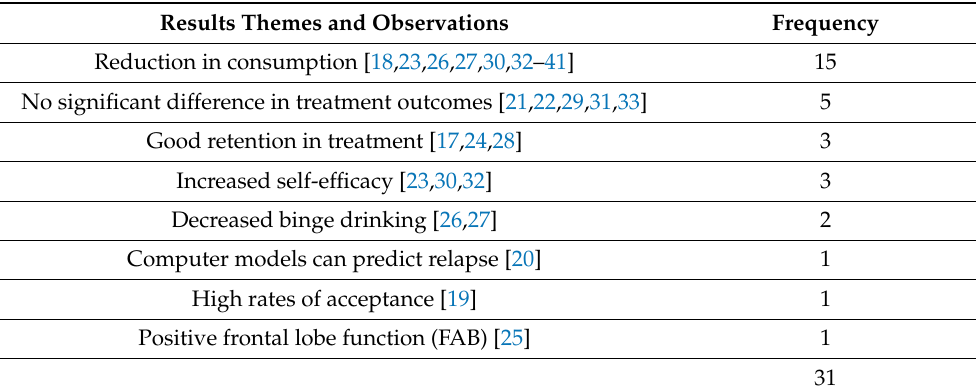
Table 3. Results to the